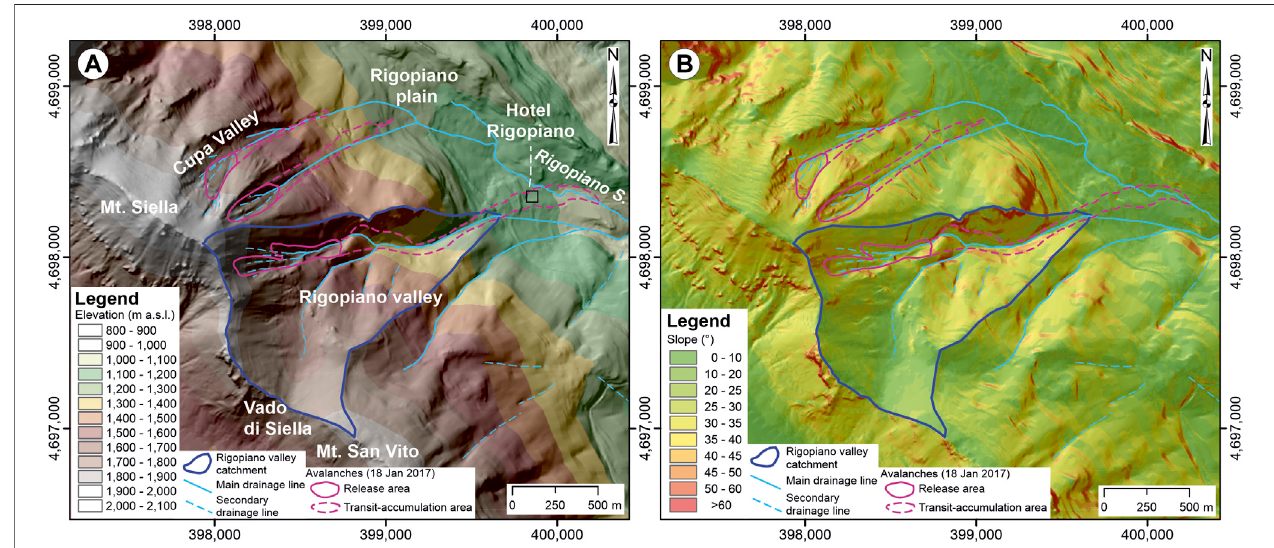
FIGURE 8 | Orography of the Rigopiano study area: (A) elevation map; (B) slope